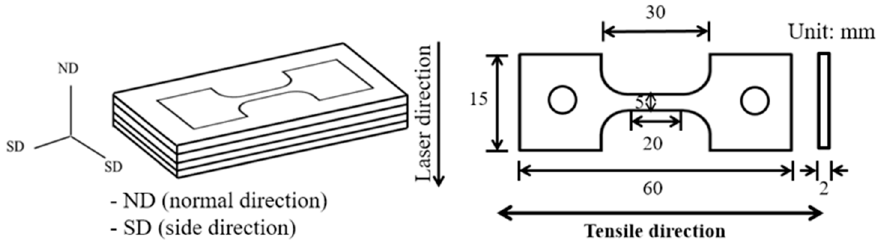
Figure 1. Dimensions of the selective laser melting (SLM) Ti-6Al-4V tensile specimen.